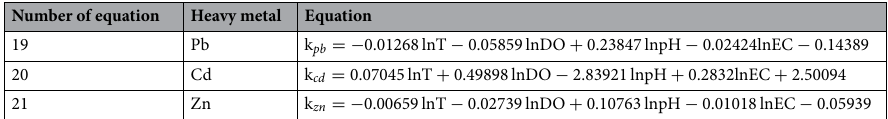
Table 6. Logarithmic equations of the reaction coefficient of heavy metal dissolved phase.